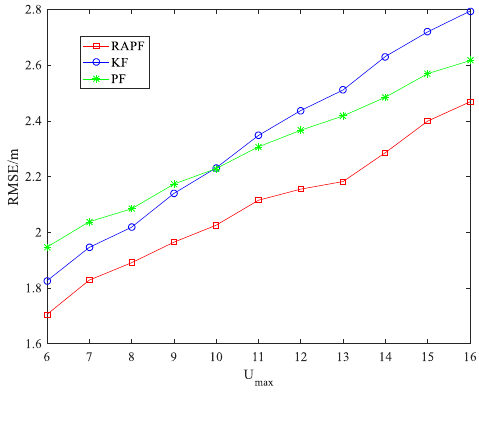
Figure 16. The RMSE the U max .